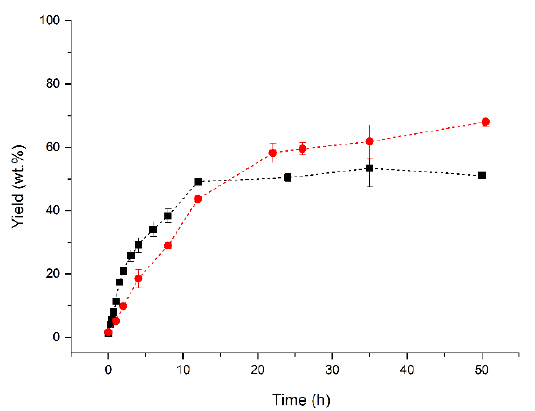
Figure 3. Profiles of ester mass yield vs. reaction time for esterification/transesterification of SODD with isoamyl alcohol in presence of two MS concentration (9 wt% ( • ) and 39 wt% ( (cid:4) )). Reaction